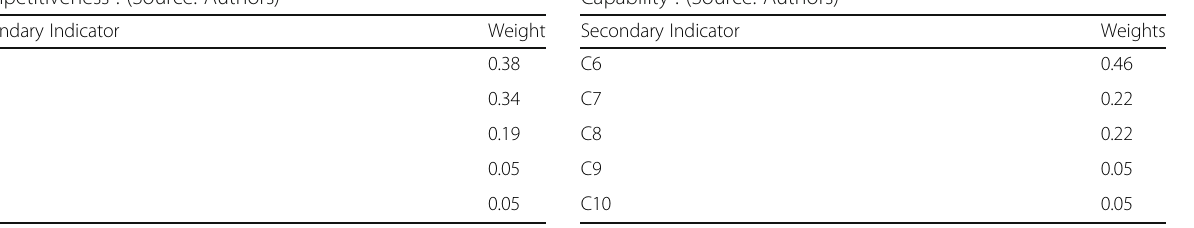
Table 12 Weight of secondary indicators under “